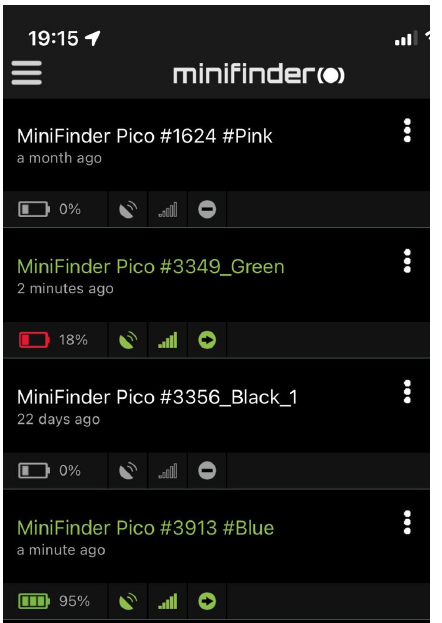
Figure 6. Device GPS unit status. Table 3. Colour indicators and Device